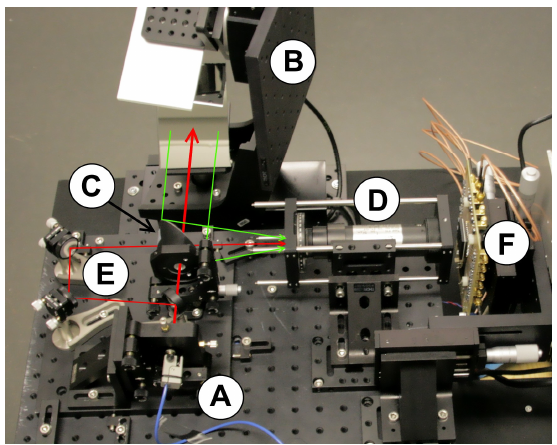
Fig.1. The optical setup: A laser pulse (A) is collimated and sent to a 2D scanner setup (B). An off-axis parabolic mirror (C) is used as a primary light collecting optic. A spectrograph (D) disperses the colors of the return and trigger (E) pulses to an APD array, which converts the light to analog voltage waveforms.